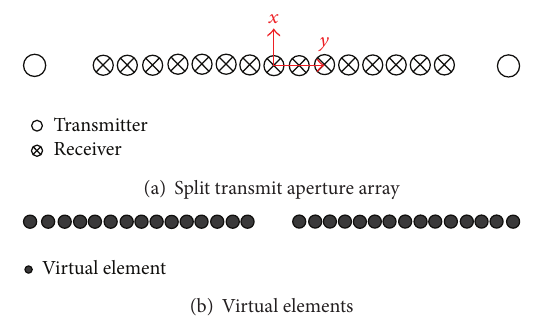
Figure 6: Split transmit virtual aperture array and its virtual